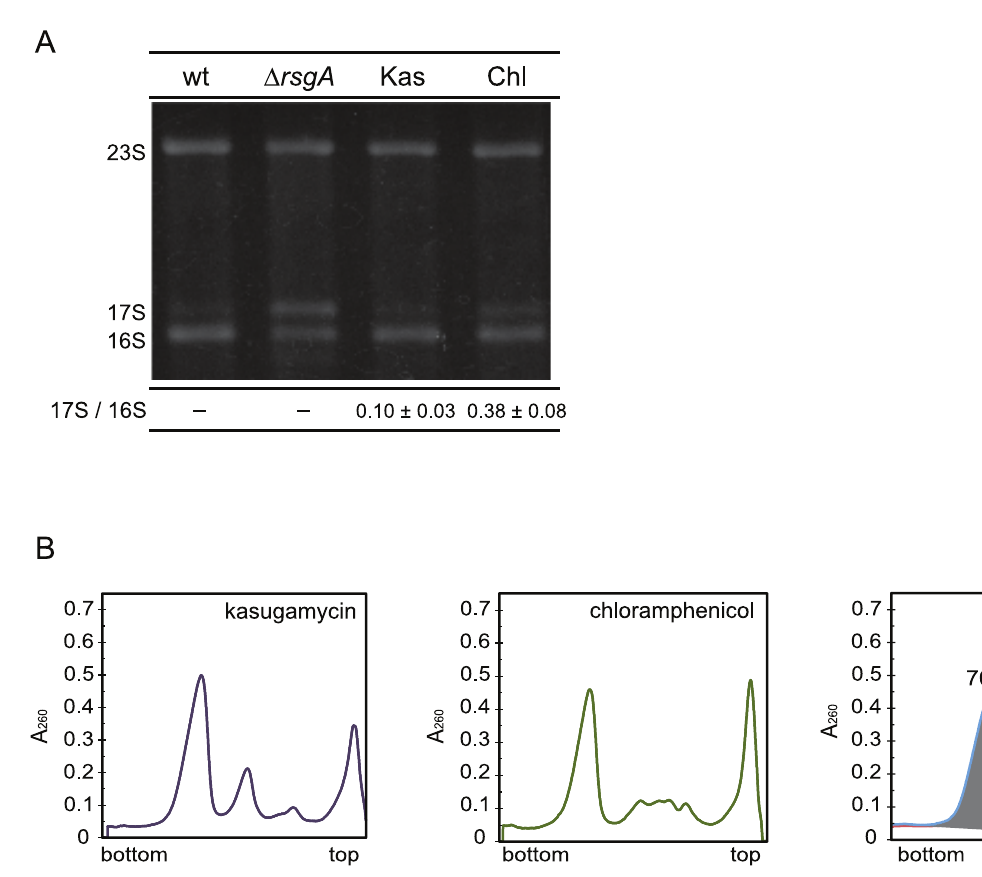
Figure 3. Effects of protein synthesis inhibitors on processing of 17S RNA and on subunit association. Wild-type cells were grown at 37 u C in LB medium with 80 m g/ml kasugamycin (Kas) or 1.2 m g/ml chloramphenicol (Chl). (A) One m g of total RNA fraction prepared from wild-type, n rsgA , or drug-treated cells was electrophoresed on 1.8% agarose gel. The ratio of the amount of 17S RNA to that of 16S rRNA is shown below each lane. (B) Ribosome profiles of wild-type cells, RsgA-deletion cells and wild-type cells treated with protein synthesis inhibitors are shown. Cells were lysed with alumina powder and the cell debris was removed as described in Materials and Methods. Ten A 260 units of crude cell extracts were fractionated by 5%–20% sucrose density gradient ultracentrifugation.